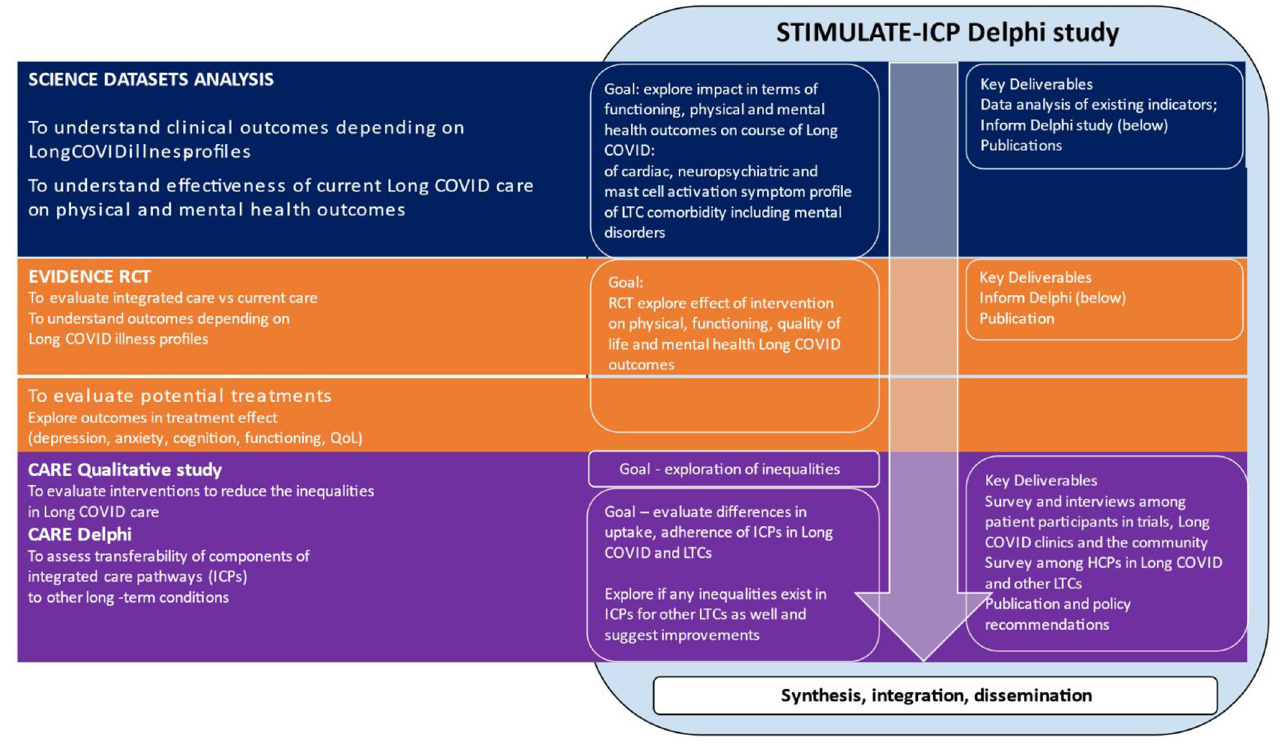
Fig 1. Flow chart showing the integration of STIMULATE-ICP DELPHI within overall STIMULATE-ICP.